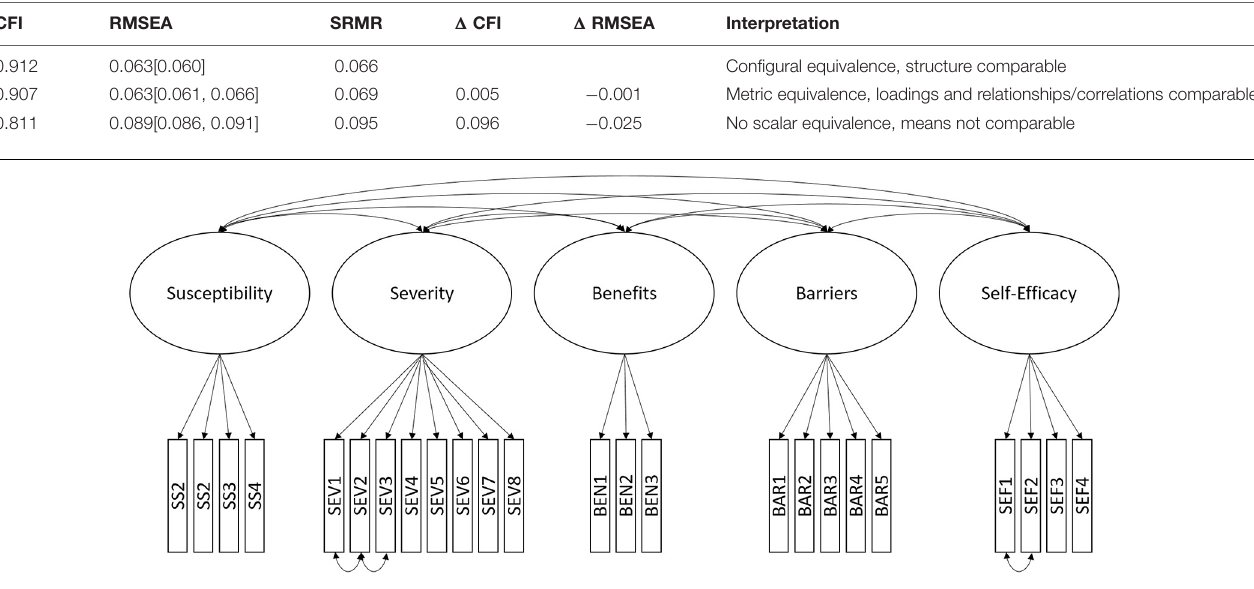
FIGURE 1 | Conceptual model of the final CFA